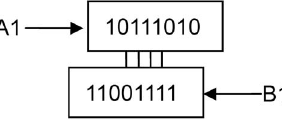
Figure 1. Example of A 1 and B 1 .